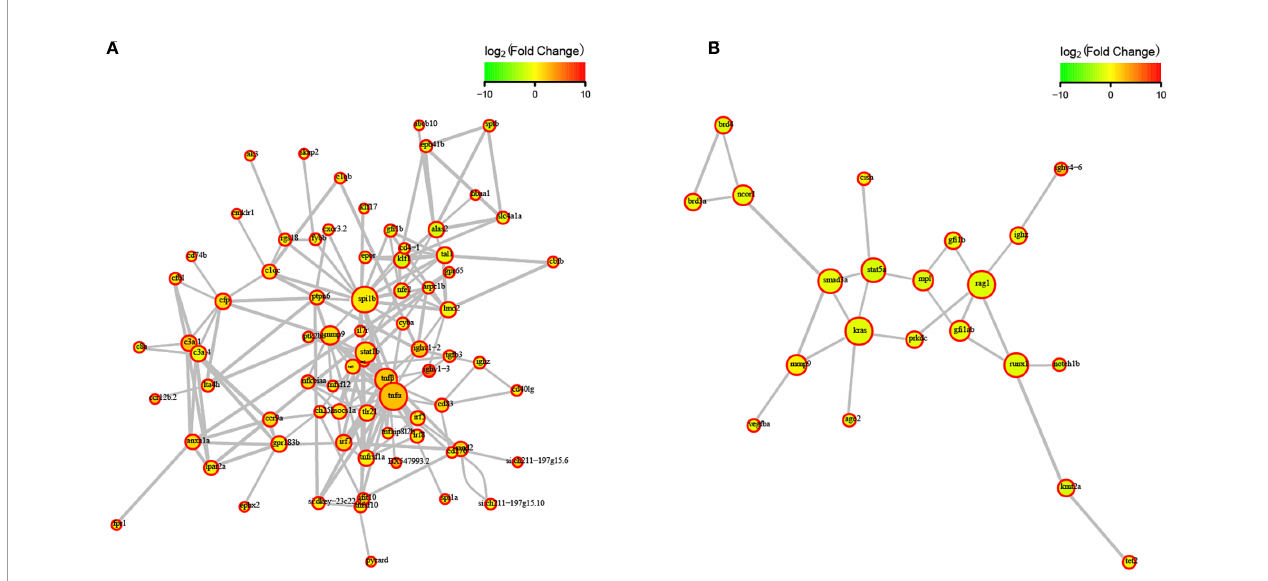
FIGURE 6 | STRING network analysis on DEGs annotated in GO: immune system process. (A) WT-10d_vs_WT-0h. (B) Mut-10d_vs_Mut-0h. The nod represents proteins, bigger means more interaction with others. The red color means upregulated DEGs, and the green means downregulated